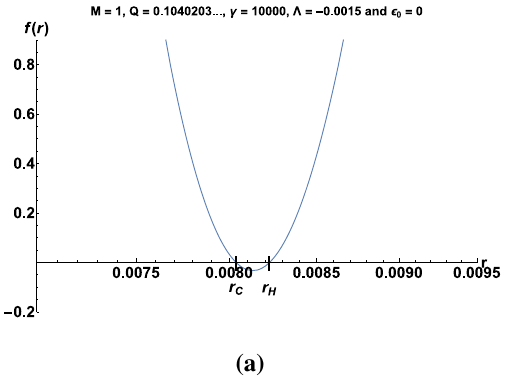
Fig. 4 Examples of f ( r ) from near-extremal black hole in asymptotically anti de-Sitter space. (Left) the near-extremal black hole of the type r C ∼ r H . (Right) the double (near-)extremal black hole of the type r C = r H and r (cid:6) − = r (cid:6) +